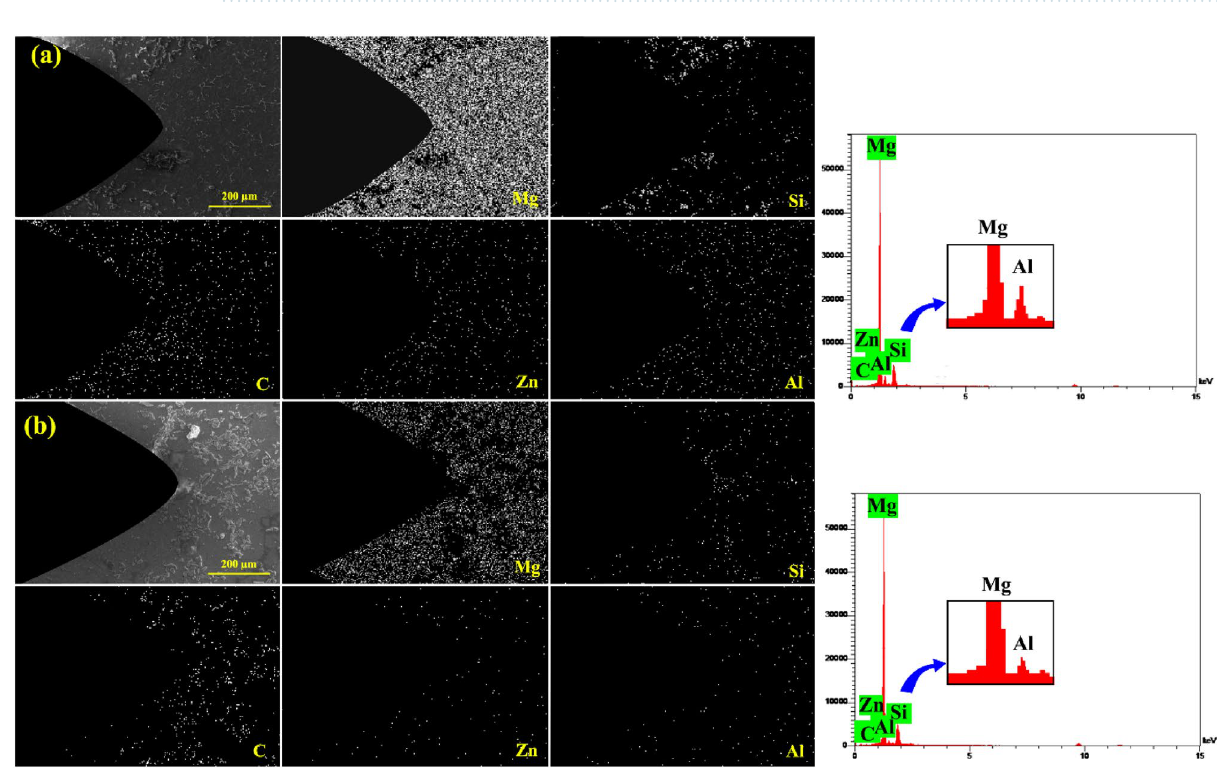
Figure 12. Elemental map analysis of the sample: ( a ) before thermal cycle, and ( b ) after 300 thermal cycles at 350